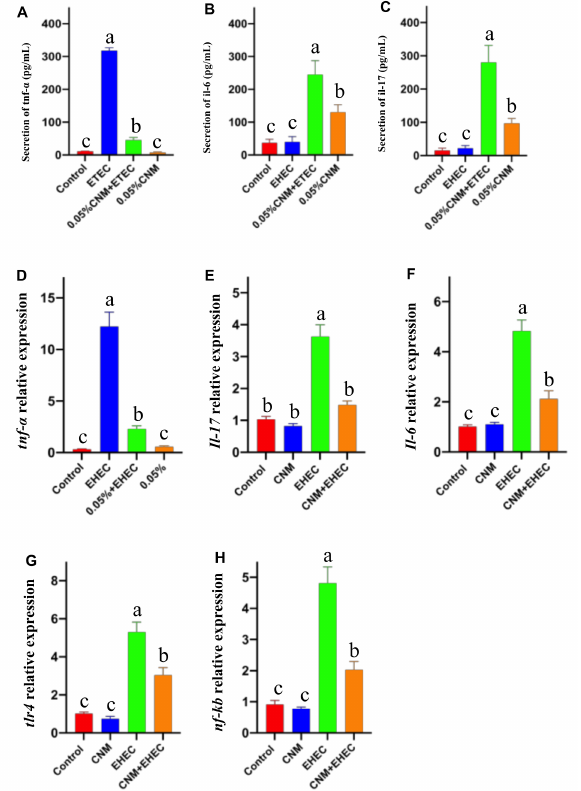
Figure 6. CNMs significantly reduced proinflammatory cytokine production and mRNA expression in E. coli O157 -infected IPEC-J2 cells. Cell supernatant and cells were collected and proinflammatory cytokine production ( A – C ) and mRNA expression ( D – H ) were analyzed. Data are means ± SEM from 6 biological data. Means with different lowercase letters differ significantly by Tukey’s test ( p < 0.05).